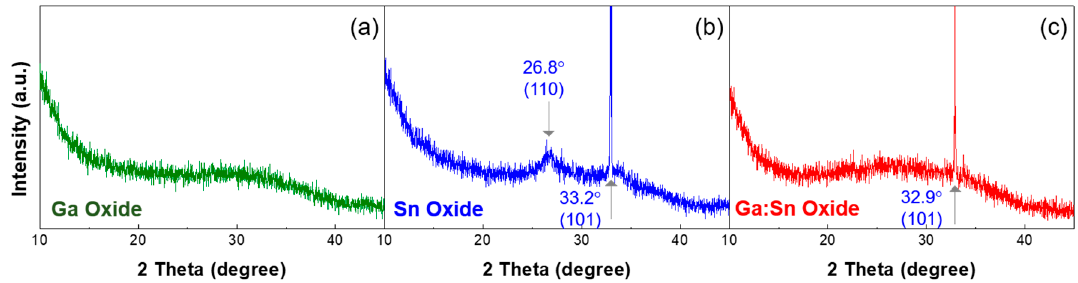
Figure 4. XRD (X-ray diffraction) patterns of the ( a ) Ga oxide, ( b ) Sn oxide, and ( c ) Ga:Sn oxide films, respectively.